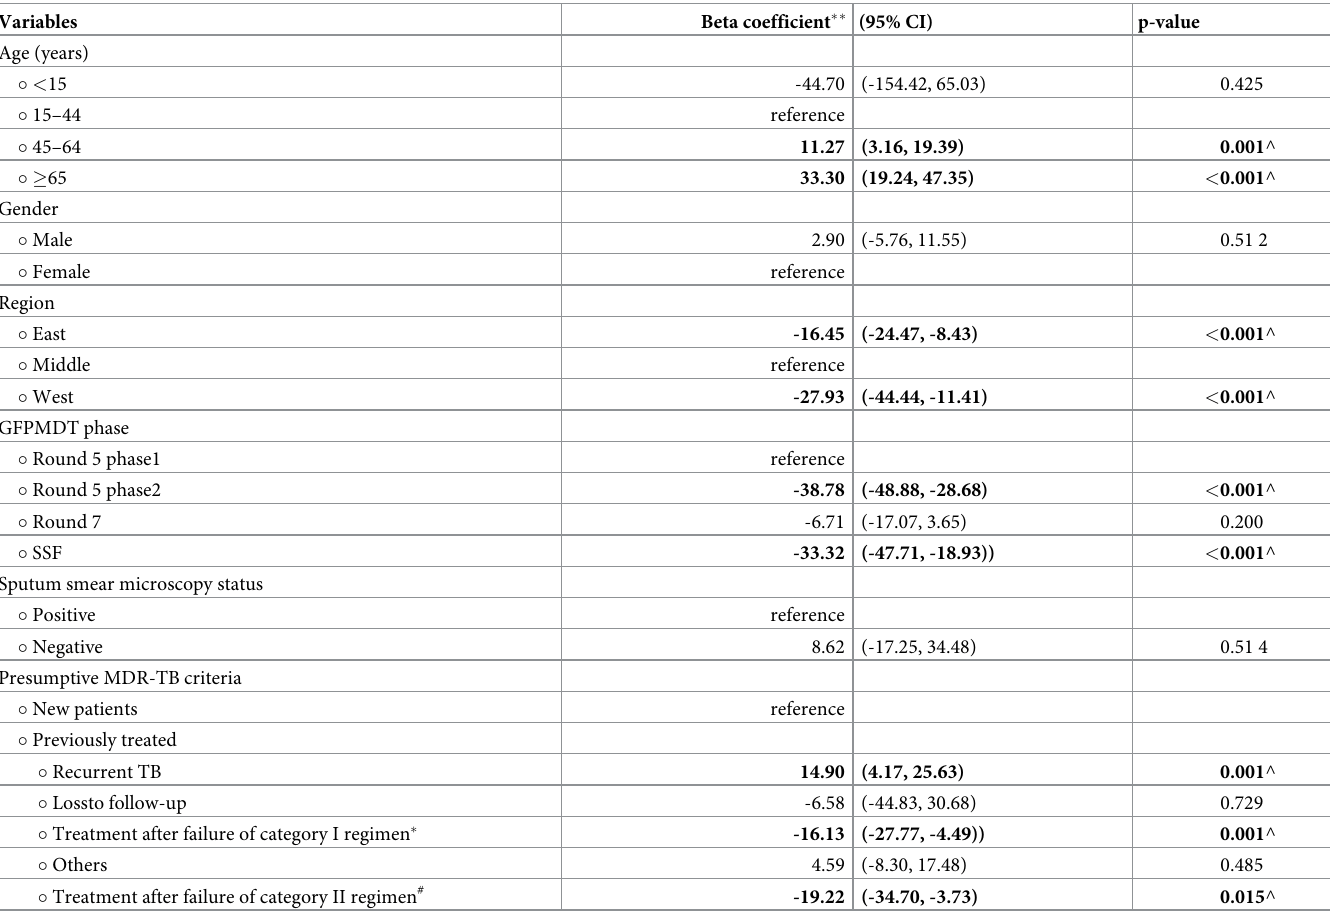
Table 7. Multivariable linear regression for factors associated with total delay (between eligibility for DST and treatment initiation) among bacteriologically-con- firmed MDR-TB patients registered for treatment under GFPMDT project in China, October 2006-June 2013 [N =